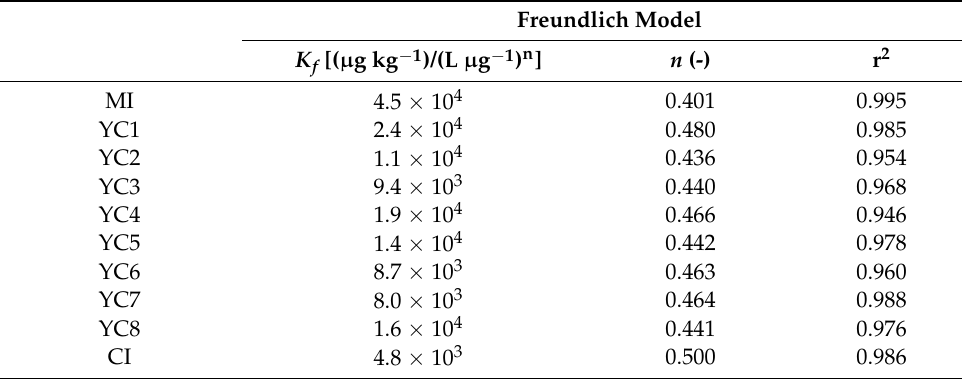
Figure 2. Cesium uptake isotherms for YC1–8. Each symbol represents the experimental results with the error bar (2 σ ), and the black dotted line shows the Freundlich isotherms. The symbols and dashed lines of blue and red indicate the experimental data and Freundlich isotherms for MI and CI, respectively. Table 2. Parameters of Freundlich isotherms for the illitic clay